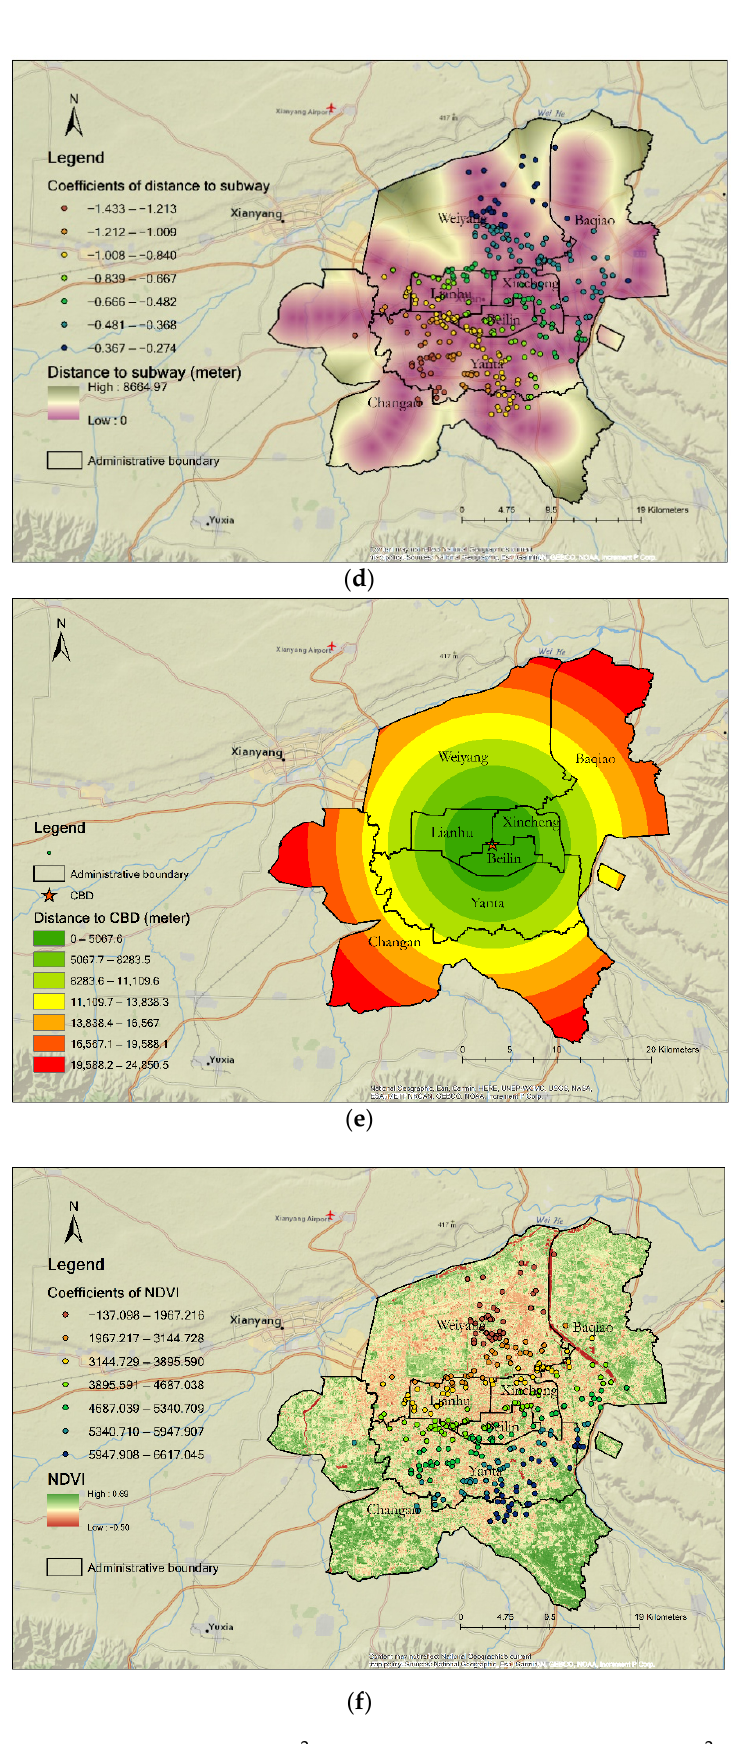
Figure 4. The maps of local R 2 and five significant factors. ( a ) local R 2 ; ( b ) density of factory; ( c ) distance to food; ( d ) distance to subway; ( e ) distance to CBD; and ( f )